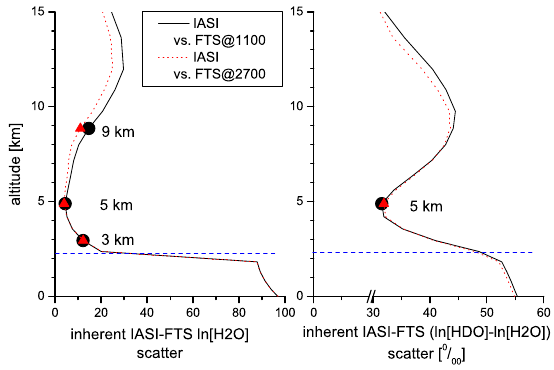
Table 5. Relative difference between our IASI and FTS H 2 O prod-